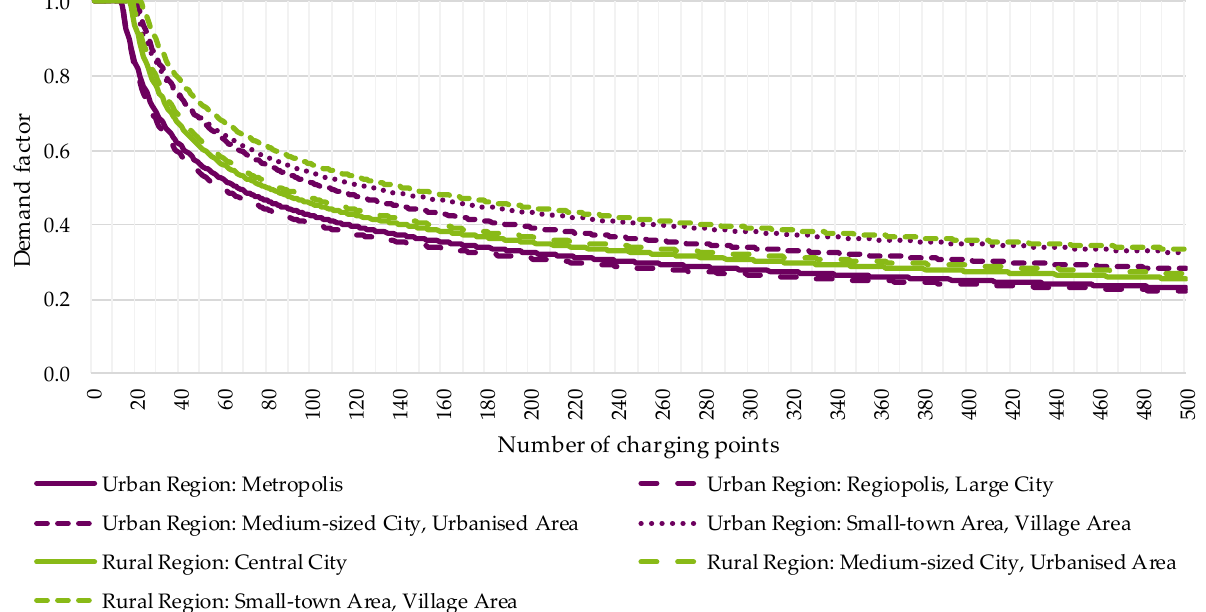
Figure 23. Demand factors (ordinate) for 3.7 kW charging power and seven different area types.